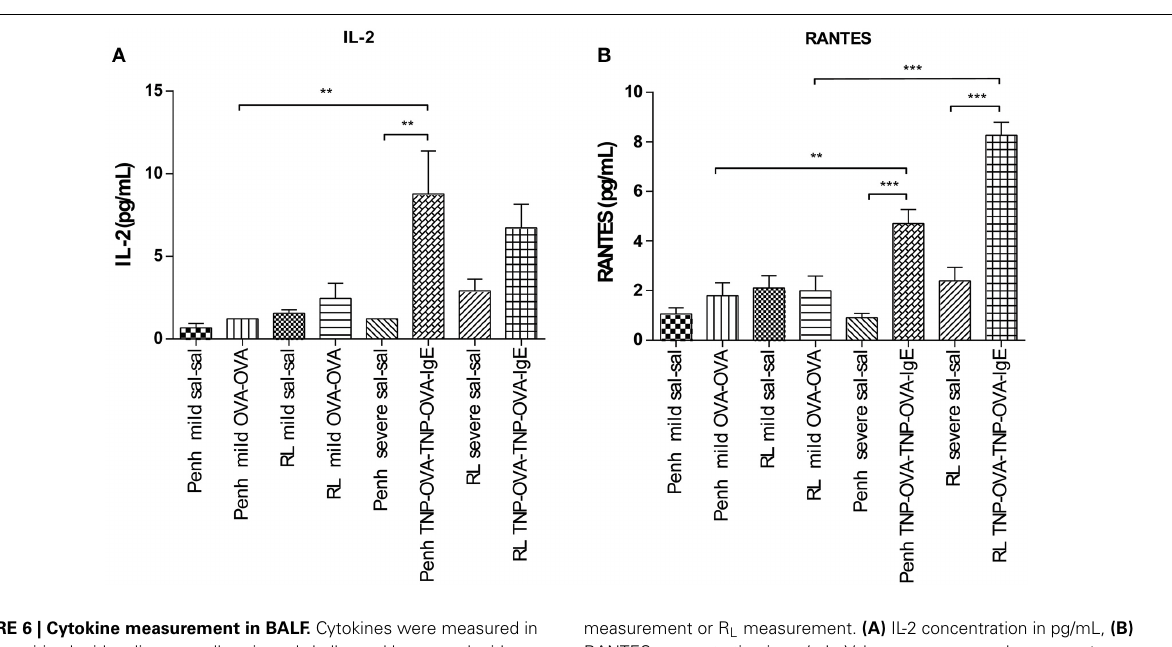
FIGURE 6 | Cytokine measurement in BALF. Cytokines were measured in mice sensitized with saline or ovalbumin and challenged by aerosol with saline or ovalbumin (mild) and mice sensitized with saline or TNP-OVA and challenged intranasally with saline or TNP-OVA-IgE (severe) after Penh